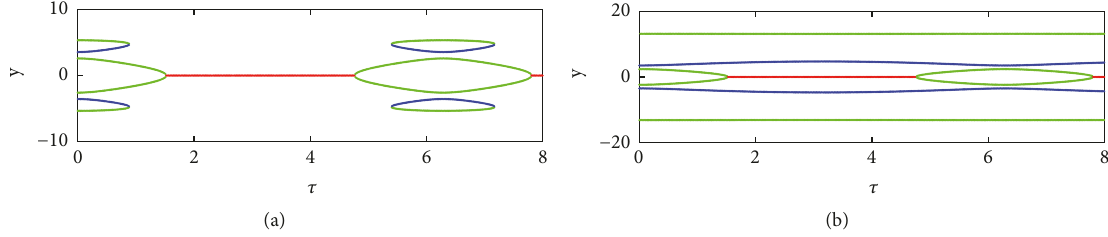
Figure 4: Bifurcation diagram of the energy harvesting system with 𝜏 for 𝑘 = 0.01 . (a) 𝛽 = 0.005,𝛼 = 0.15 ; (b) 𝛽 = 0.001, 𝛼 = 0.12 . The other parameters are 𝜂 0 = 0.01,𝜂 1 = 0.25,𝛾 = 0.2 .